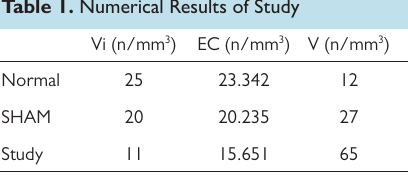
Table 1. Numerical Results of Study